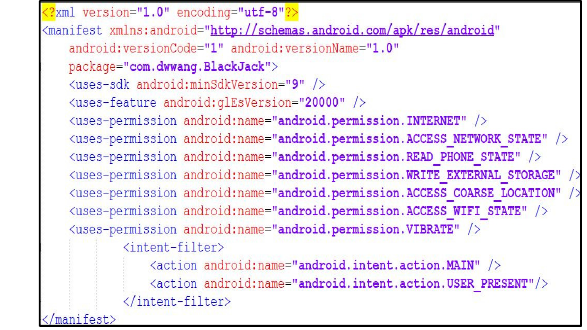
Fig. 2: Structure of Andriod Manifest